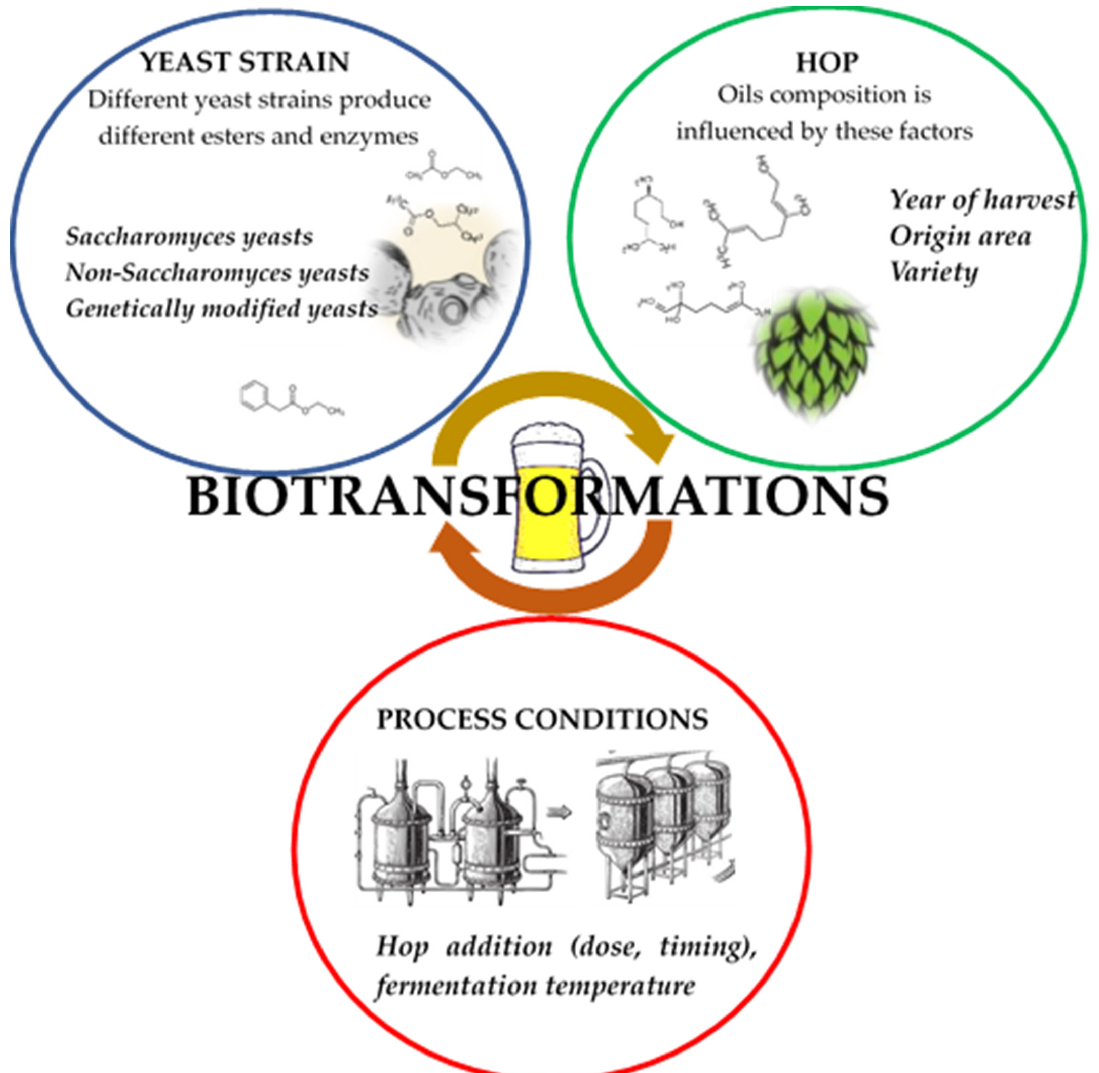
Figure 1. The factors that can in fl uence biotransformations of the aroma compounds provided by hops.